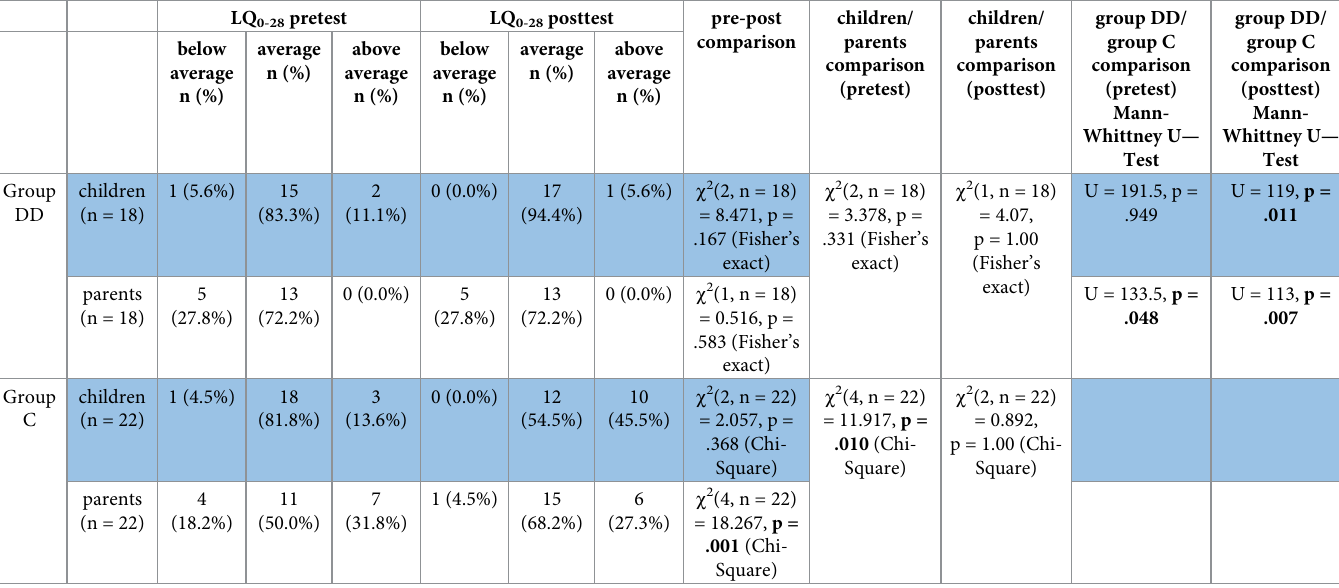
Table 5. Statistical data of quality of life: LQ 0-28